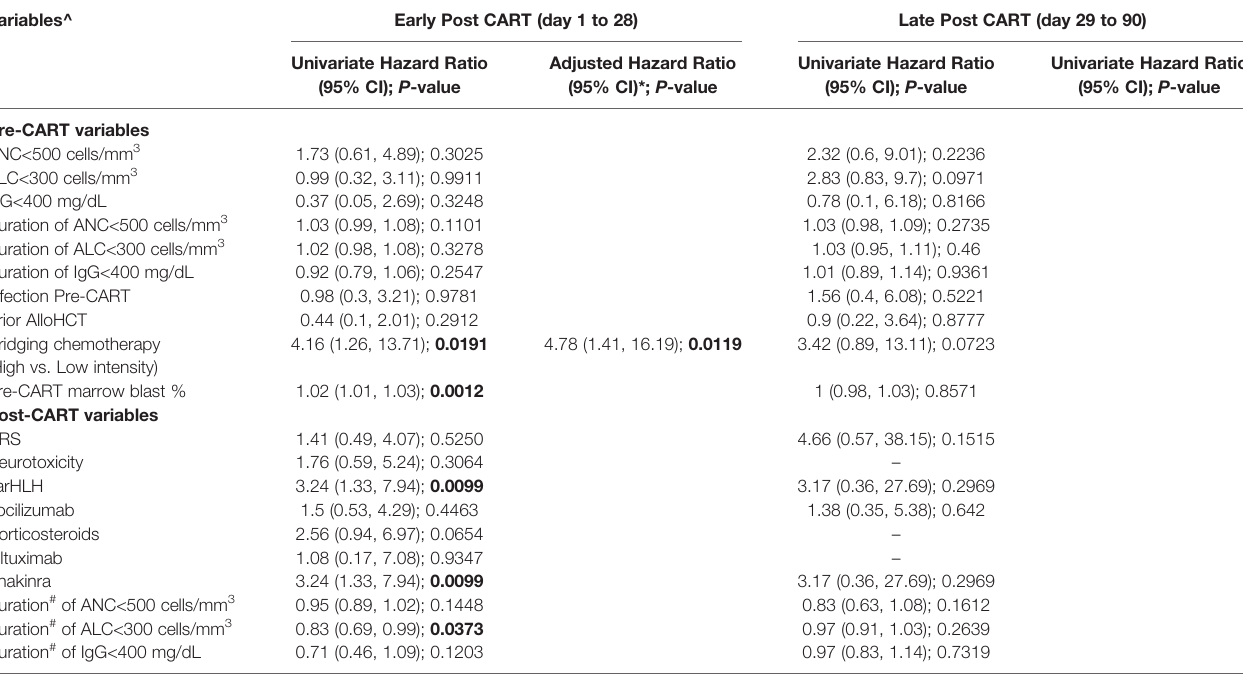
TABLE 5 | Association of pre- and post-CAR T cell therapy variables with time to fi rst infection post CAR T cell therapy. Variables^ Early Post CART (day 1 to